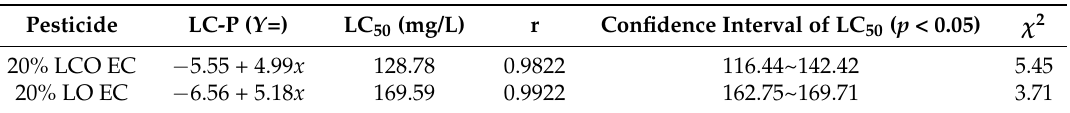
Table 1. Toxicity of Ligusticum chuanxiong oil (LCO) and lemongrass oil (LO) against Aphis citricola van der Goot (24